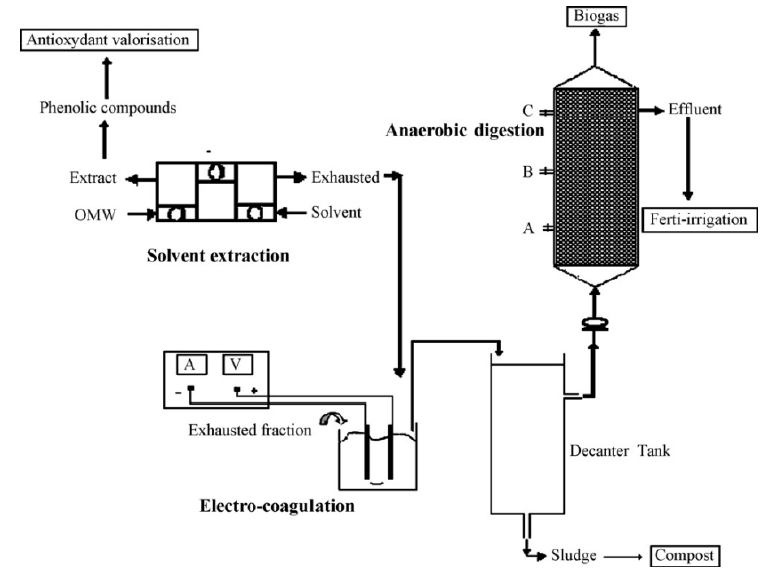
Figure 7. OMW treatment using solvent extraction, electro-coagulation, and anaerobic digestion. Reprinted with permission from Reference [109]. Copyright 2019. Elsevier.